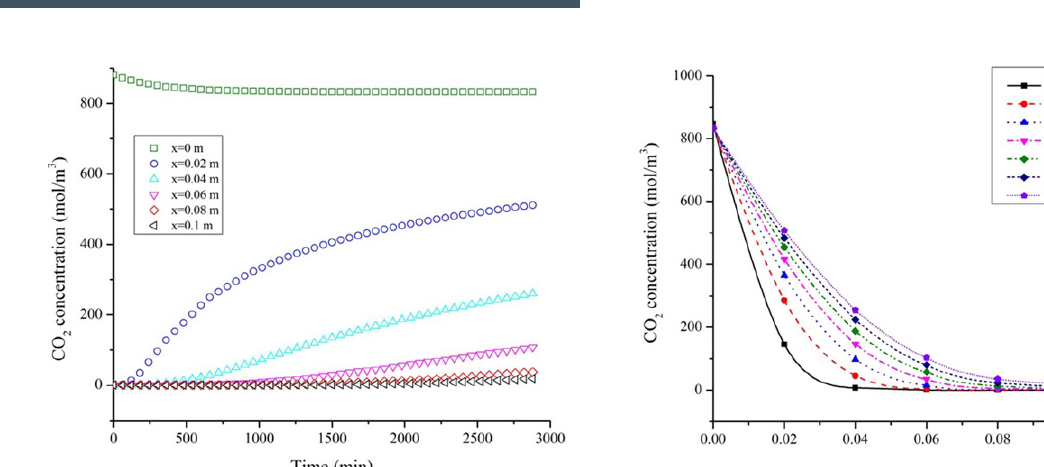
Figure 7. CO 2 concentration in formation water in the diffusion cell due to molecular diffusion mechanism at 40 ◦ C and 5900 kPa initial pressure versus time.